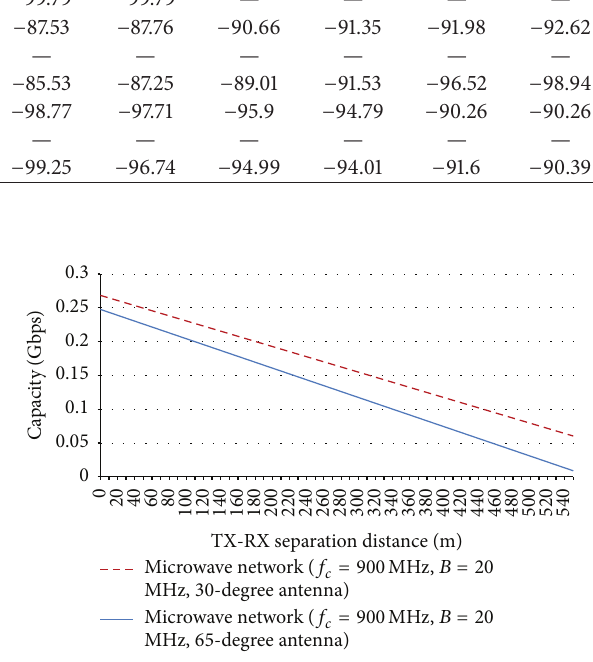
Figure 3: Capacity trend in Gbps for 28 GHz mm-wave networks using 65 ∘ and 30 ∘ transmitting antenna beamwidths.